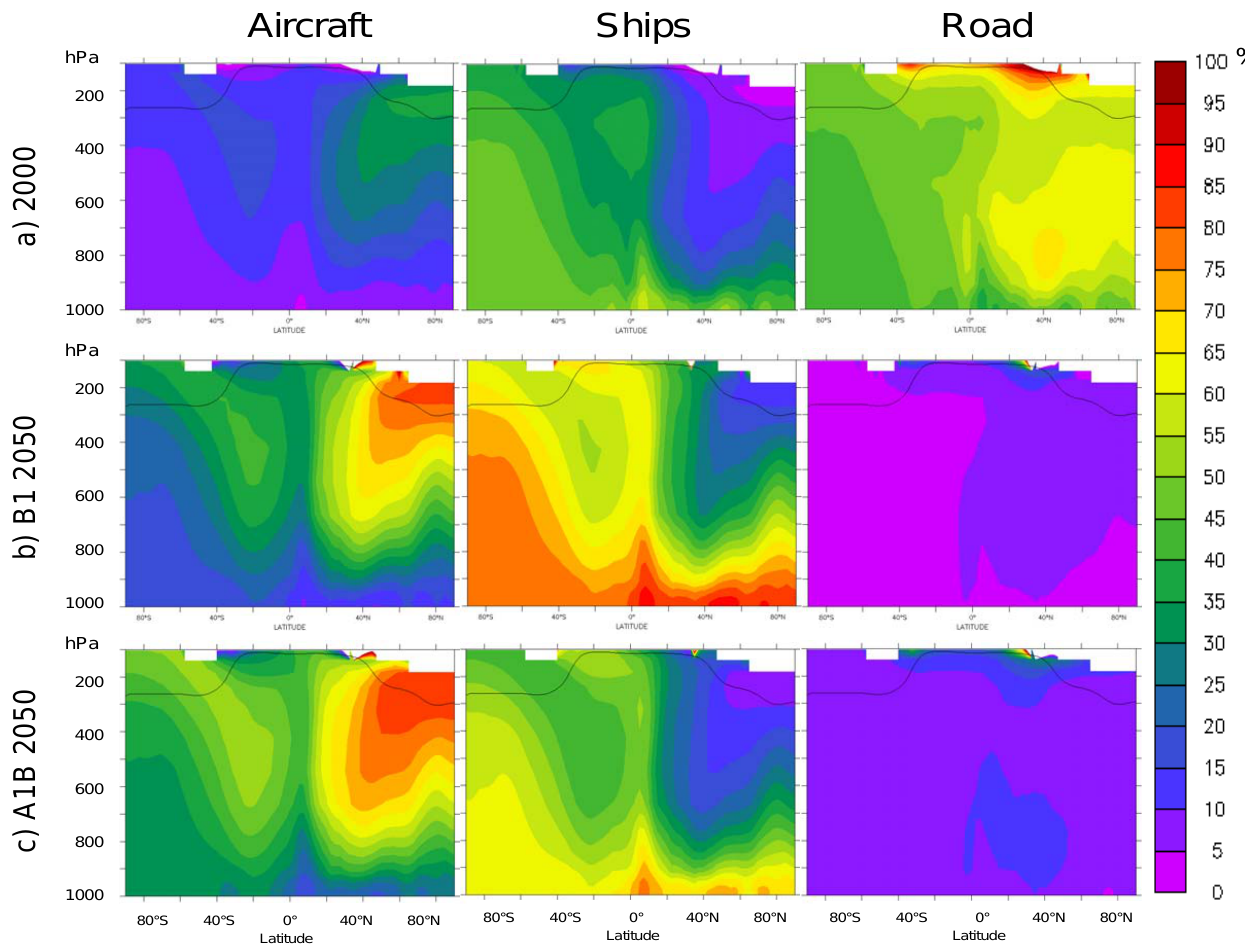
Fig. 4. Same as Fig. 2 for zonal mean ozone mixing ratio. The solid line indicates the